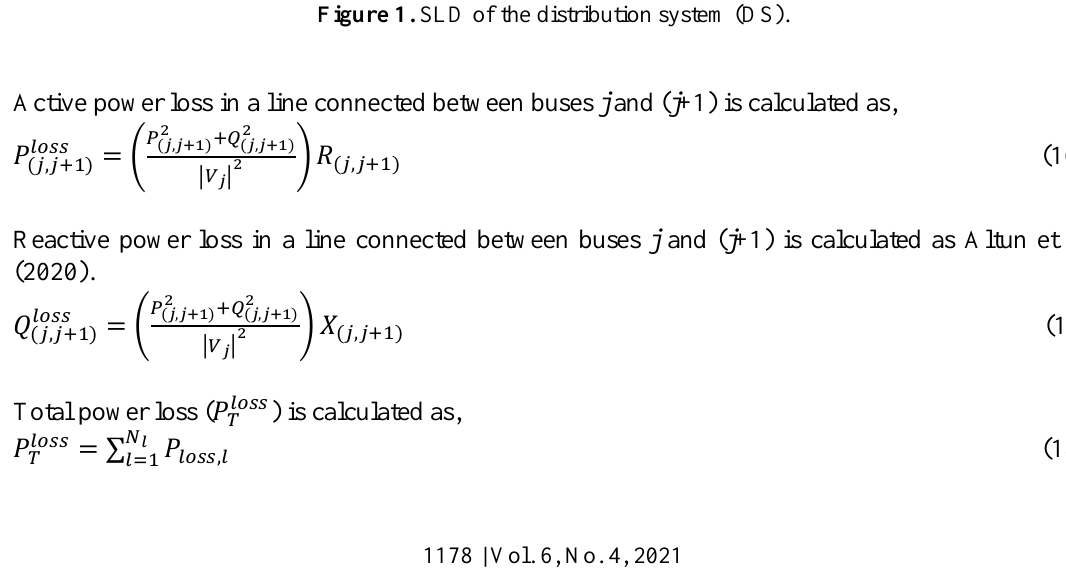
Figure 1. SLD of the distribution system